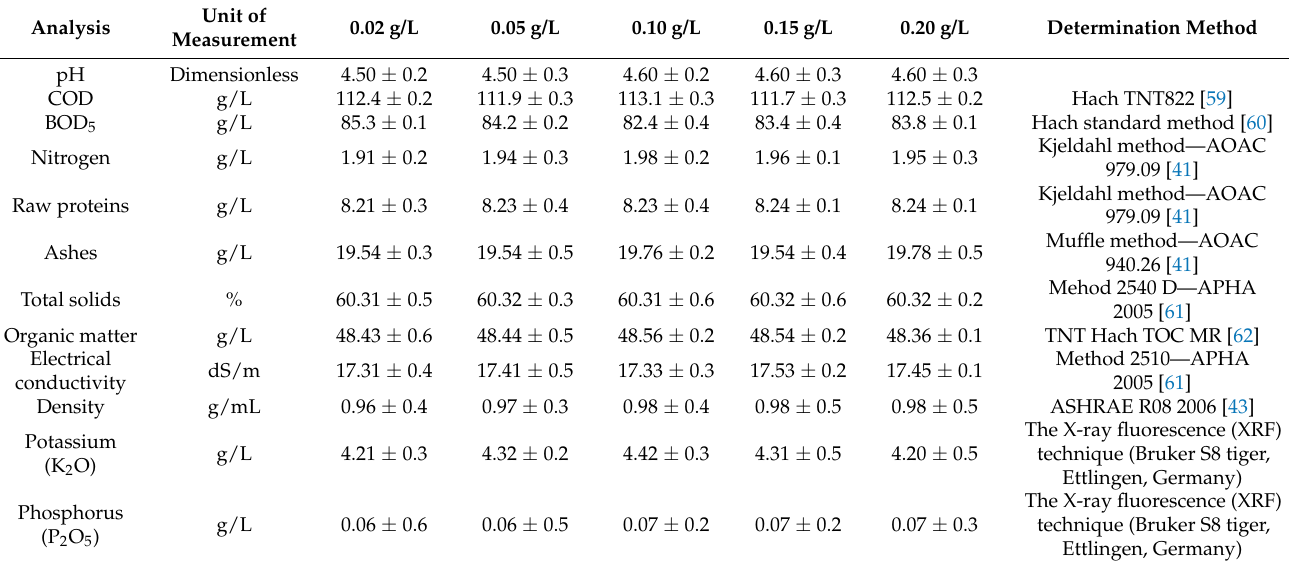
Table 4. Physicochemical analysis of